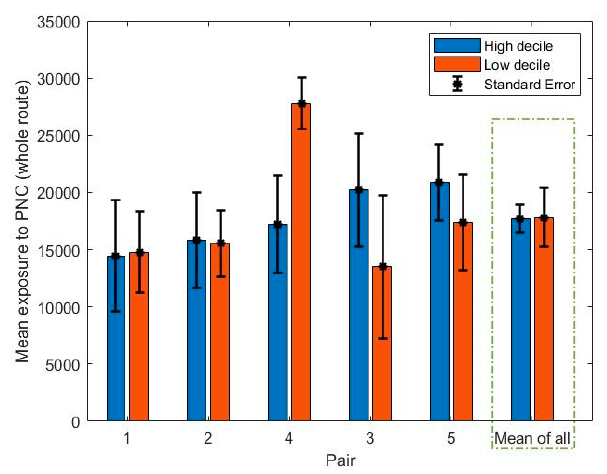
Figure 8. Bar plot of mean exposure to PNC for each pair.